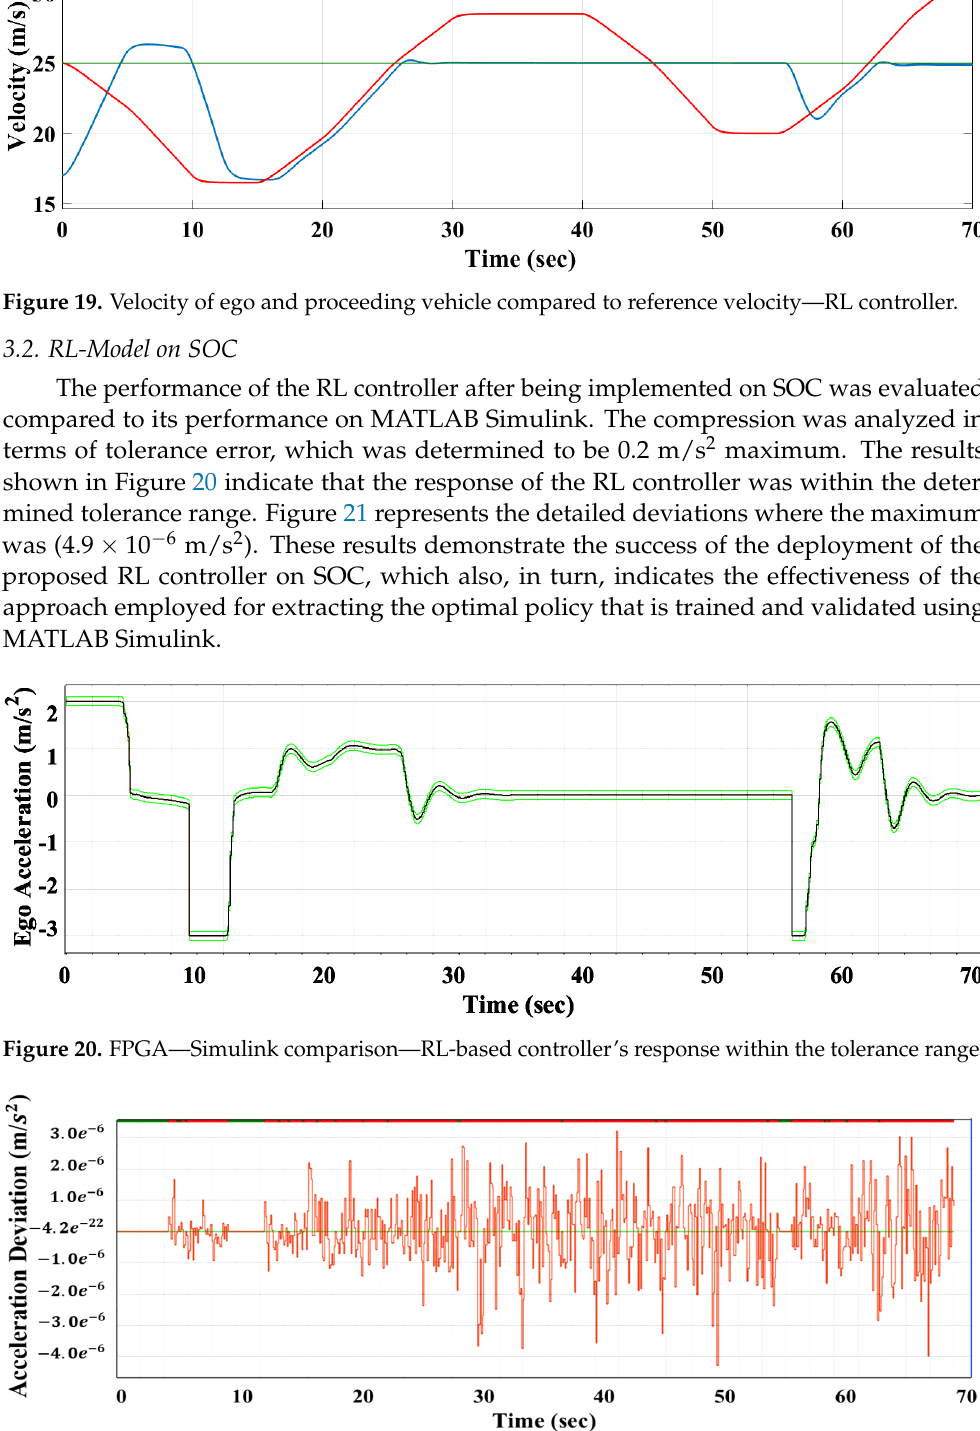
Figure 21. FPGA—Simulink comparison—RL-based controller’s response